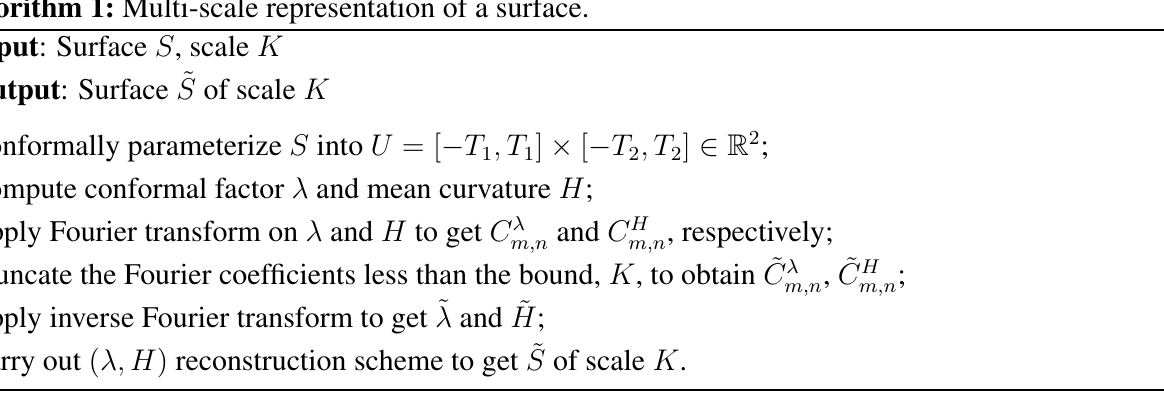
Algorithm 1: Multi-scale representation of a